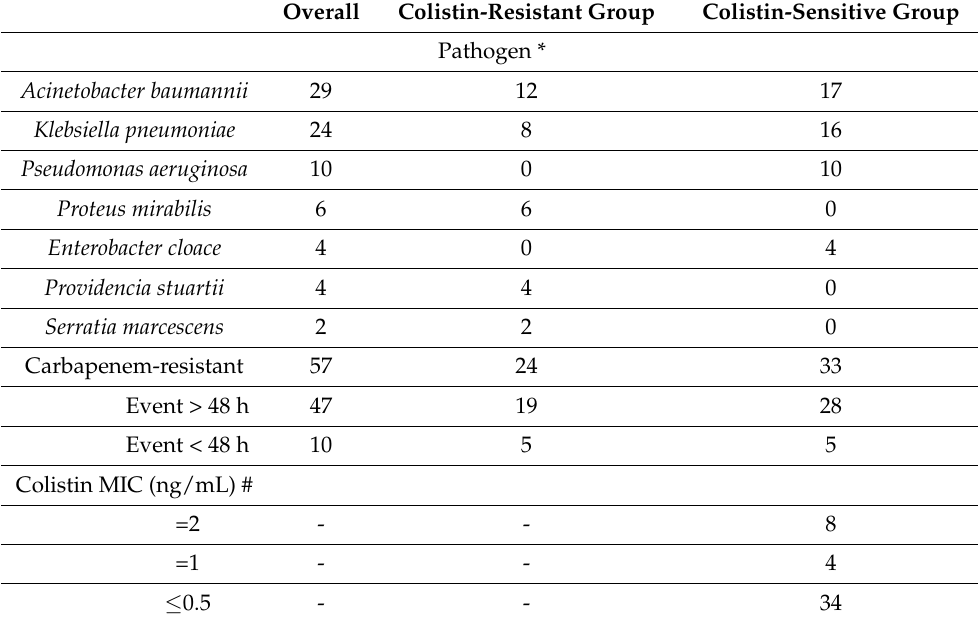
Table 2. Microbiology of index